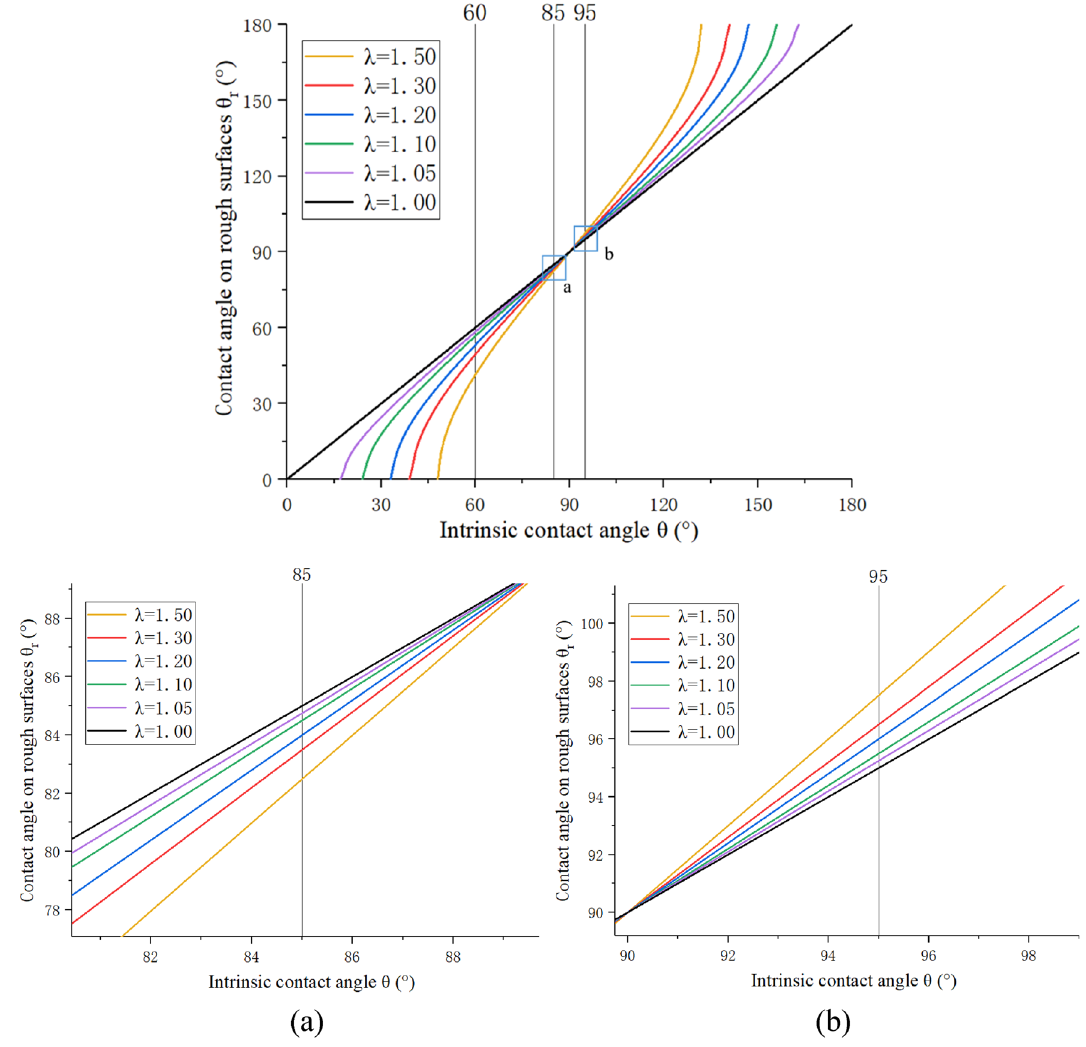
Figure 13. Wenzel model